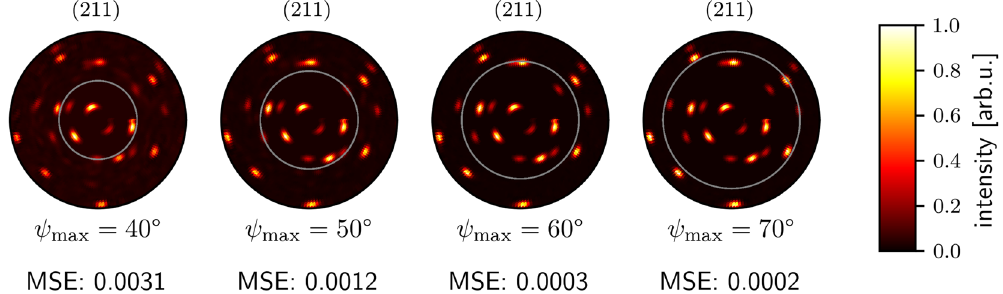
Figure 4. Comparison of reconstructions with different maximum tilt angles for the same 211 lattice plane pole plot as in Fig. 3. We plot the input sample inside of the gray circular boundary line. Outside this gray boundary, we plot the reconstruction by the corresponding reconstruction network. It is visible that given an input pole plot with ψ max = 40 ◦ , many artifacts and false poles are reconstructed. The reconstruction with ψ max = 50 ◦ shows considerably less background noise. The further steps are without noticeable differences compared to the label. For the label, please refer to Fig. 3. All pole plots are min-max normalized.